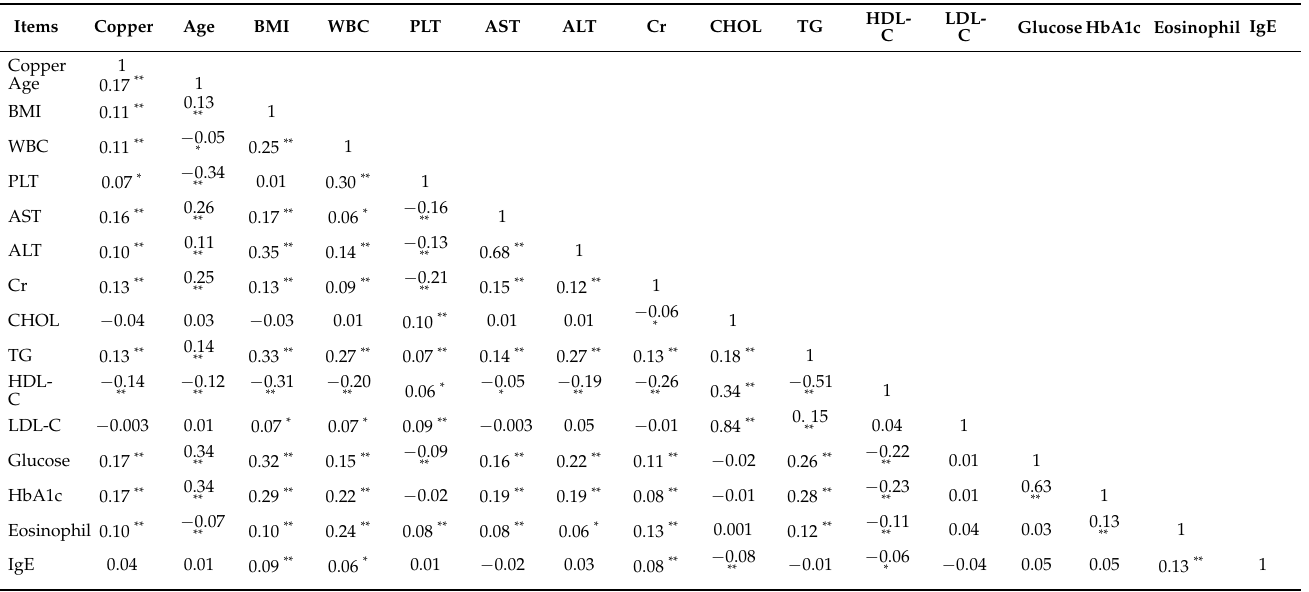
Table 3. Spearman correlation coefficient of urinary copper levels, age, BMI, and serum biochemistry levels ( n =